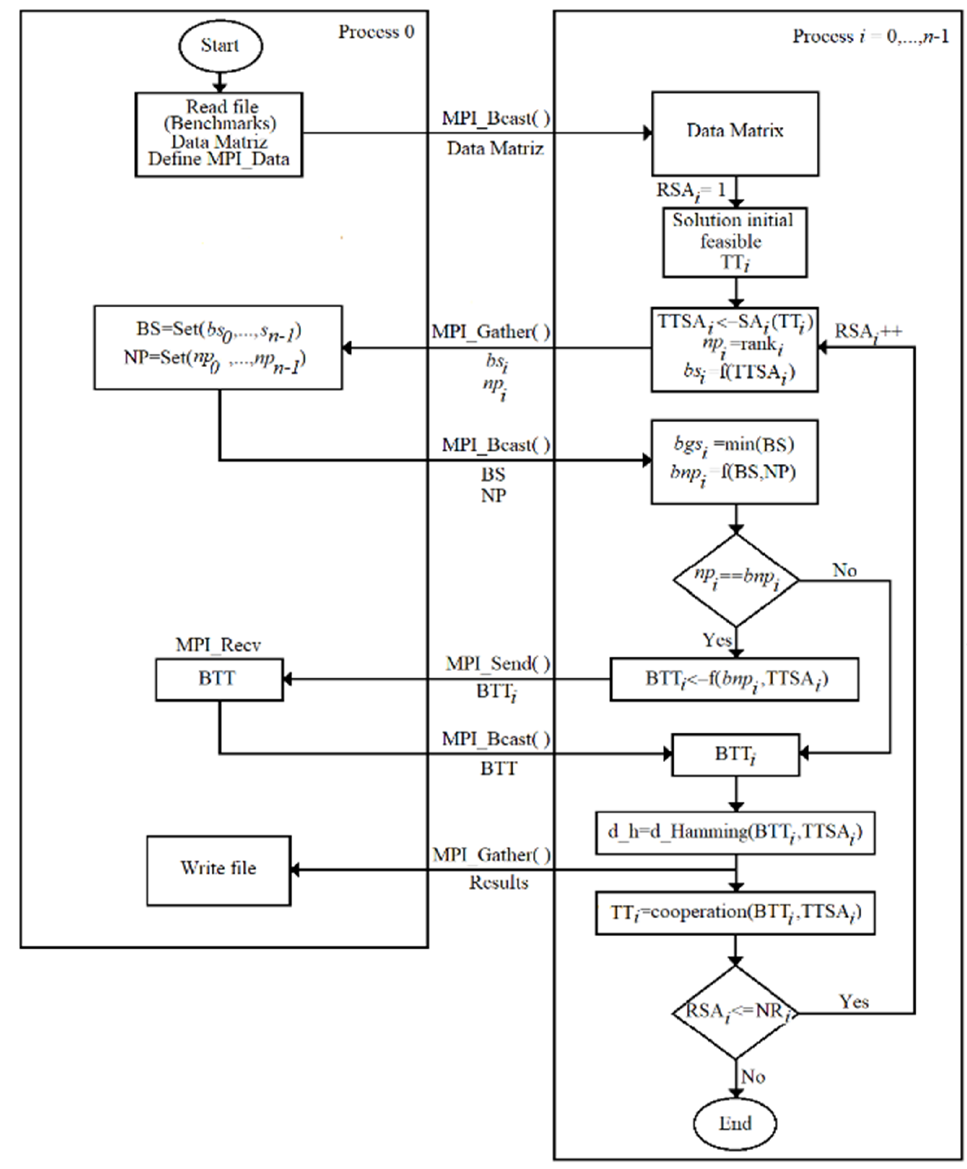
Figure 2. Simulated annealing with cooperative processes